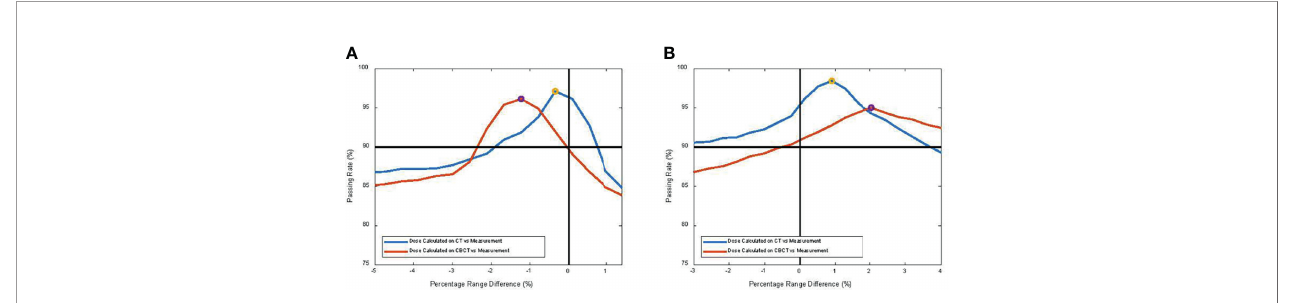
FIGURE 8 | 2D gamma passing rate with criterion of 3 mm/3% as a function of percentage range error, comparing the 2D measurement and 2D dose planes from CT or cone-beam CT (CBCT) dose for (A) the head phantom and (B) the thorax phantom,